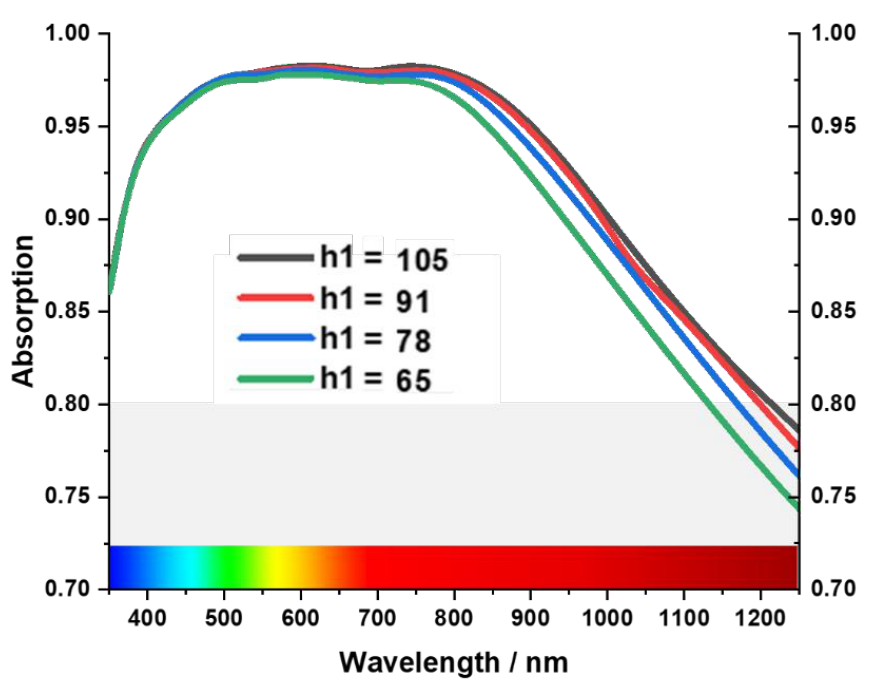
Figure 7. Effect of the thickness of the bottom tungsten layer.